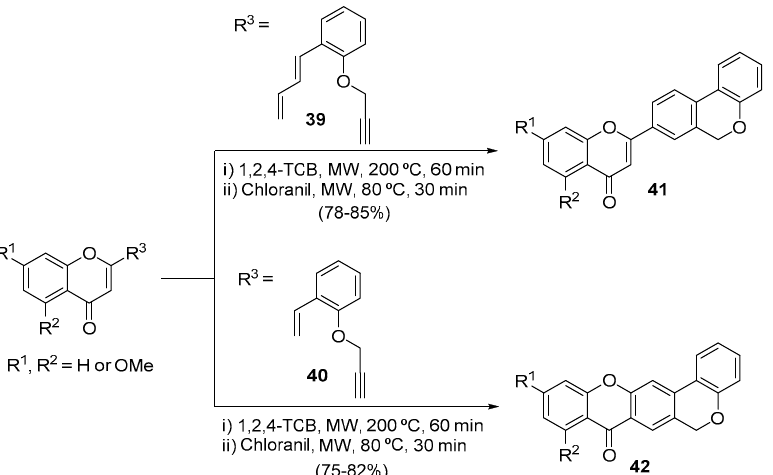
Scheme 13. Synthesis of 2-(benzo[ c ]chromenyl)-4 H -chromen-4-ones and chromeno[3,4- b ]-9 H -xan- then-9-ones using a CEM model Discover SP.